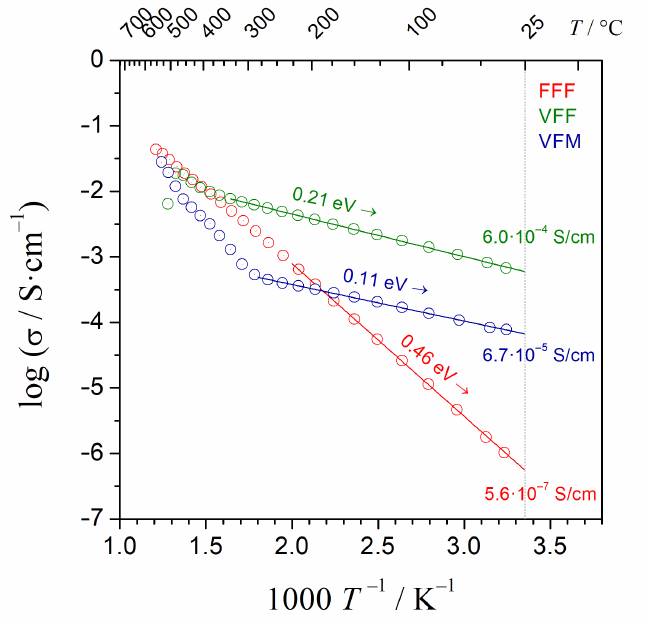
Figure 2. Electrical conductivity of nanocrystalline materials used for further cathode layer prepa- ration. The values of the activation energy and conductivity at room temperature are given for each